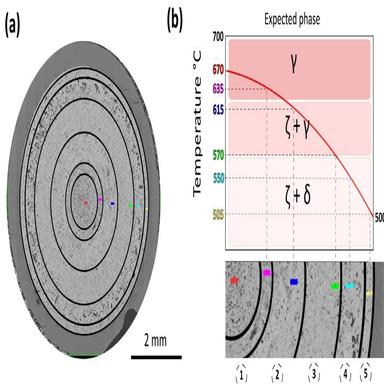
The irradiated U-Pu-Zr fuel cross section is divided into a center zone (red color) and five other concentric radial zones numbered from the center to the cladding as zone 1-5 (color coded by pink, navy, green, blue, and yellow, respectively). Each zone has a unique matrix or precipitates or both. (b) the estimated local temperature based on BER-Ⅱ irradiation experimental history. The expected phases are also presented to facilitate discussion